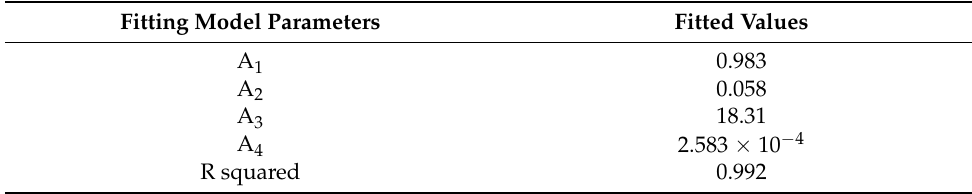
Figure 5. Non-linear fitting of the normalized dose–response versus formaldehyde concentration curve fitted by the log-logistic sigmoid dose–response model. Table 1. The fitted parameters of the dose–response model.